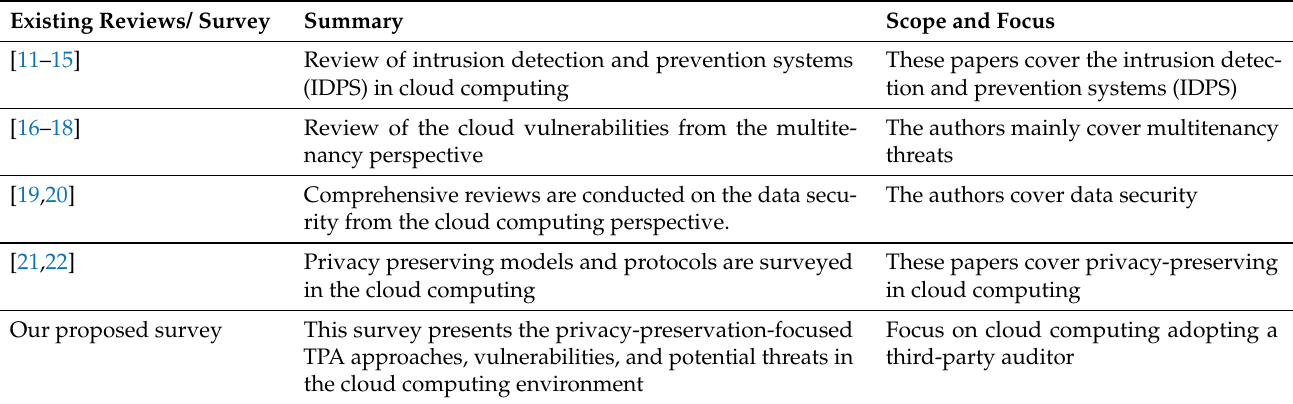
Table 1. Summary of the contributions of existing